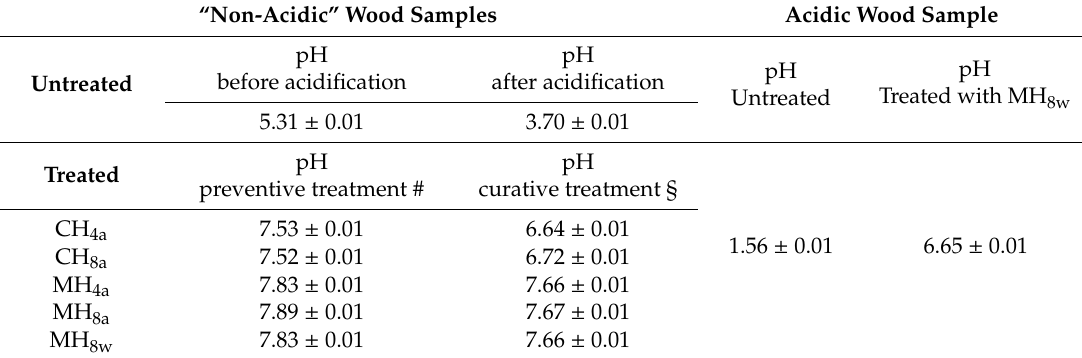
Table 2. Results of pH values refer to the “non-acidic” untreated wood samples, before and after the acidification treatment, and treated wood samples, in relation to the preventive and the curative treatments; results of pH values of the highly acidic wood sample, untreated and treated with curative treatment. “Non-Acidic” Wood Samples Acidic Wood Sample pH pH pH pH before acidification after acidification Untreated Treated with MH 8w Untreated 5.31 ± 0.01 3.70 ± 0.01 pH pH Treated preventive treatment # curative treatment § 1.56 ±